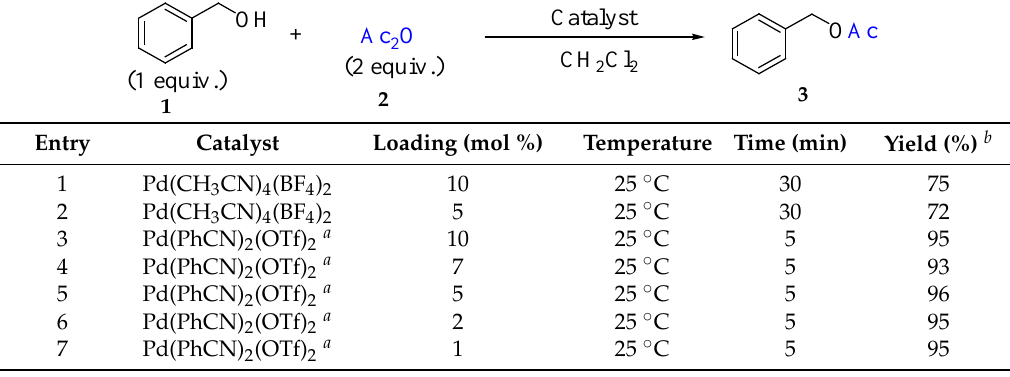
Table 1. Acetylation of benzyl alcohol catalyzed by cationic palladium (II) species.